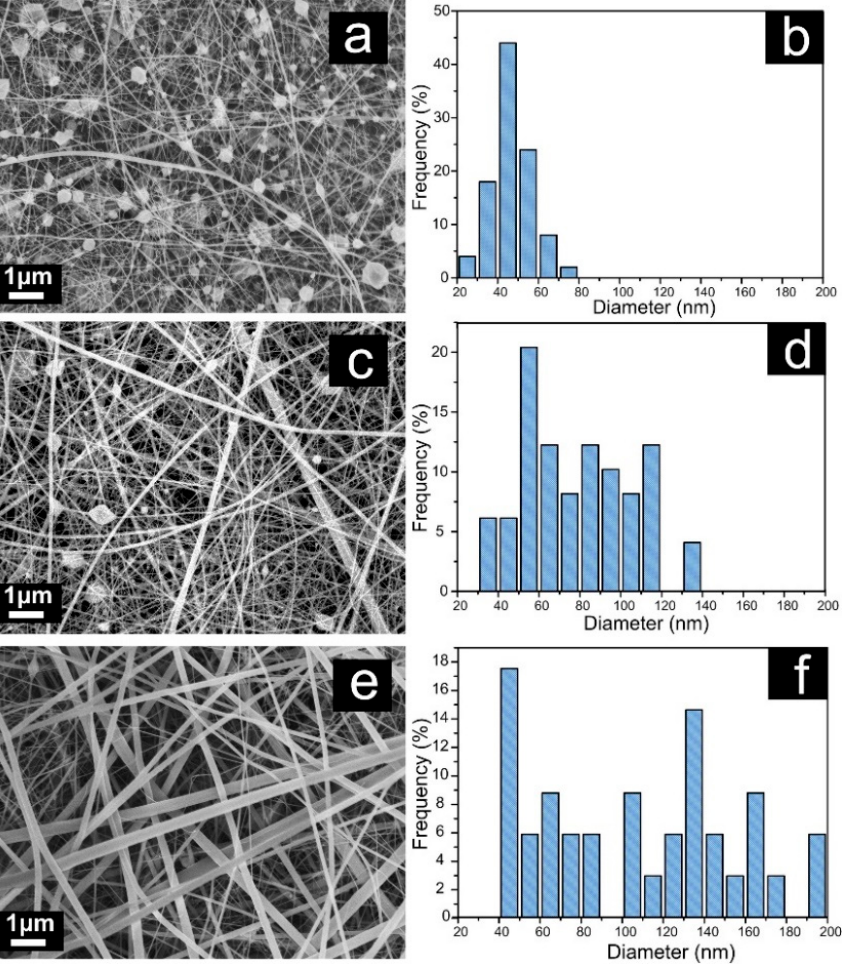
Figure 1. The morphologies and diameter distributions of electrospun CS nanofibers with various volume ratios of HFIP/FA mixture solvents: ( a , b ) 3/1 ( v / v ); ( c , d ) 6/1 ( v / v ); ( e , f ) 9/1 ( v / v ).